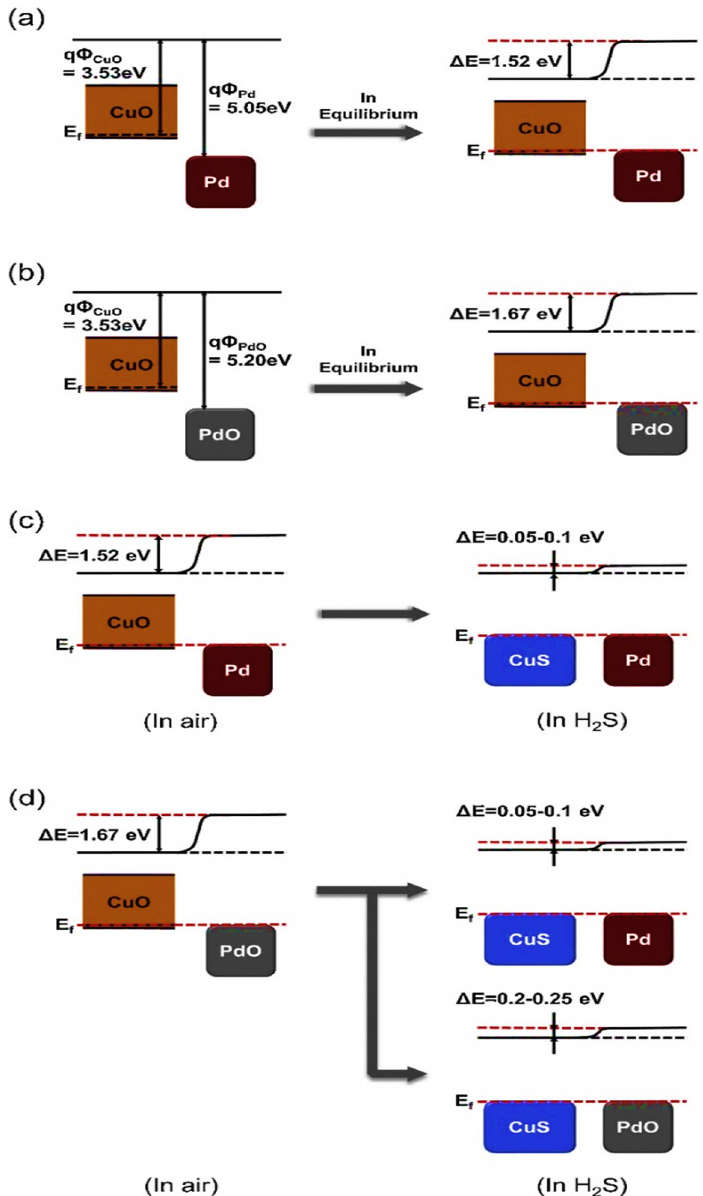
Figure 18. Schematics of the energy levels of ( a ) CuO/Pd and ( b ) CuO/PdO with the develop- ment of heterojunction barriers. Variations in the energy levels of ( c ) CuO/Pd and ( d ) CuO/PdO heterostructures in the presence of H 2 S gas. Reproduced from [110] with the permission of